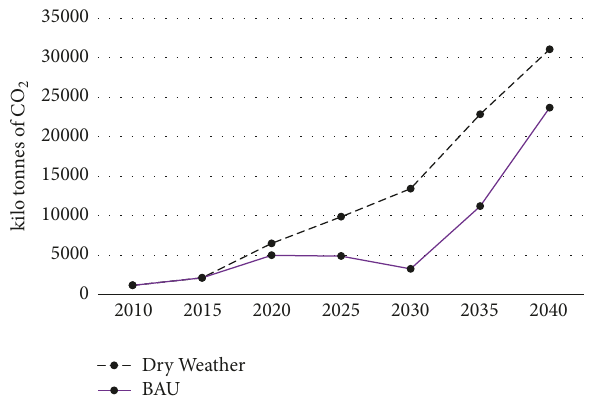
Figure 7: CO 2 emissions projections scenarios